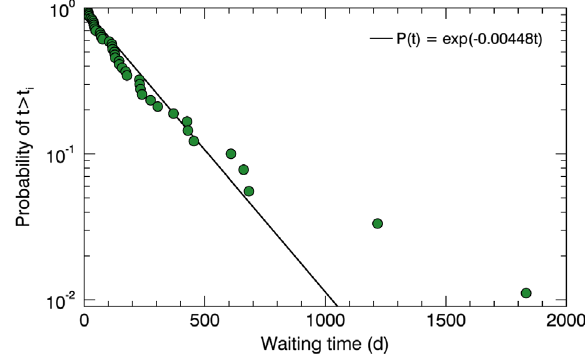
Fig. 3. Distribution of waiting times between SEP episodes and the exponential fi t for waiting times under